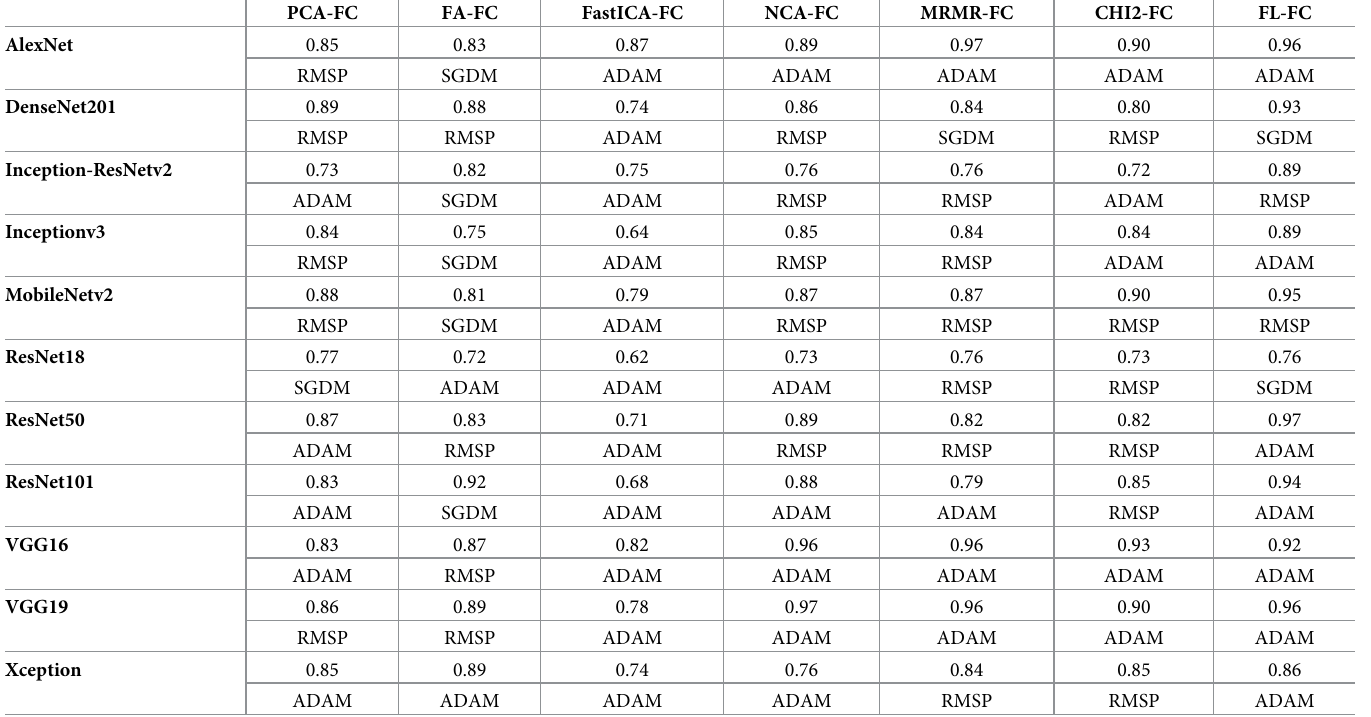
Table 13. The best FC learning optimizer for each combination method and its average classification performance (using Recall metric). PCA-FC FA-FC